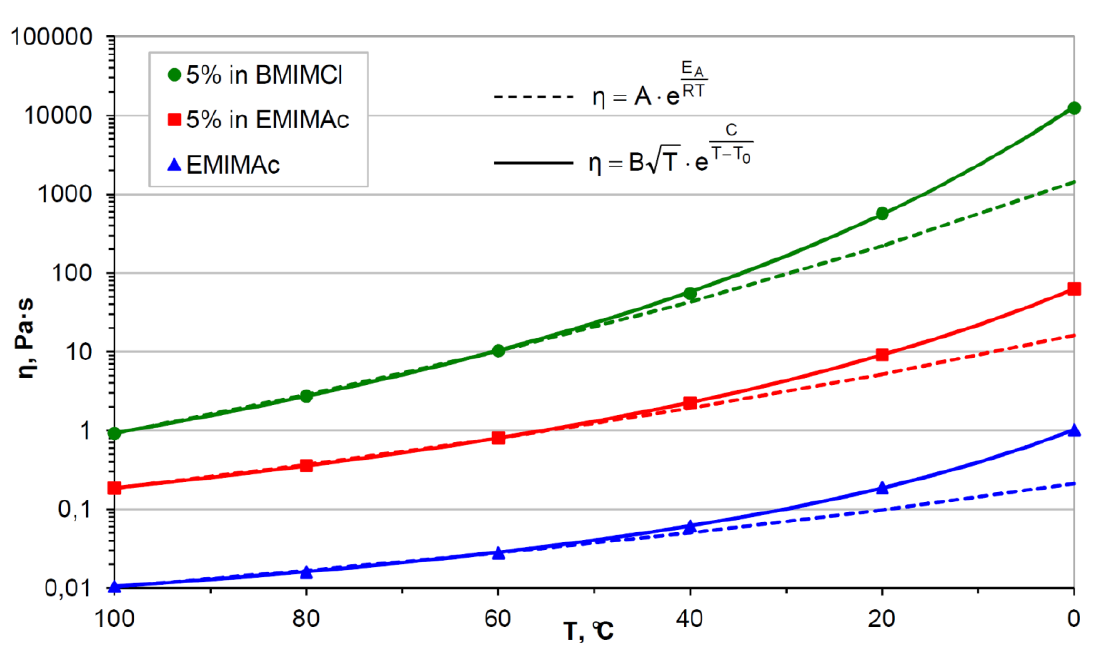
Figure 3. Temperature dependence of the viscosity of microcrystalline cellulose solutions in 1-ethyl-3-methylimidazolium acetate (EMIMAc) and 1-butyl-3-methylimidazolium chloride (BMIMCl). Dotted lines represent extrapolation based on the 60–100 °C-interval according to an Arrhenius equation. Straight lines representing the experimental behavior were calculated by a Vogel-Fulcher-Tamman equation, adapted from